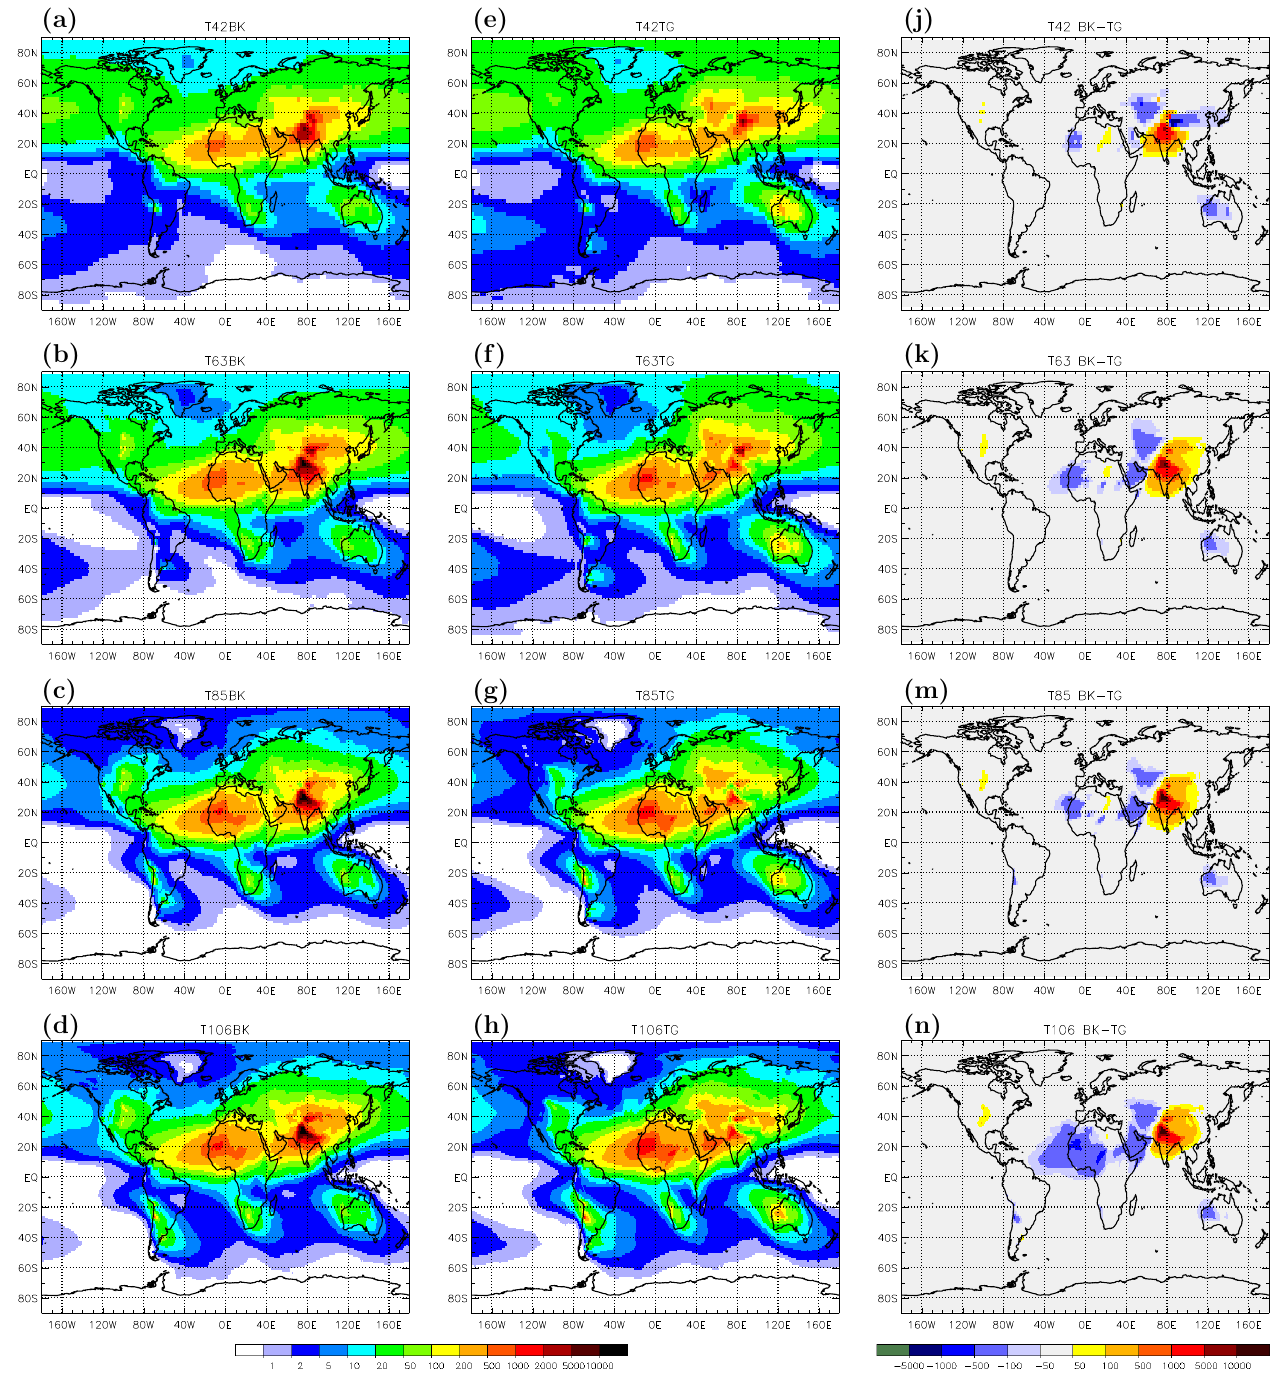
Fig. 3. Simulated five-year mean dust column mass (mg m − 2 ) using the dust emission schemes of Balkanski et al. (2004) (left column) and Tegen et al. (2002) (middle column) and for the spectral model resolutions T42 (1st row), T63 (2nd row), T85 (3rd row), and T106 (4th row). The right column shows the difference of BK minus